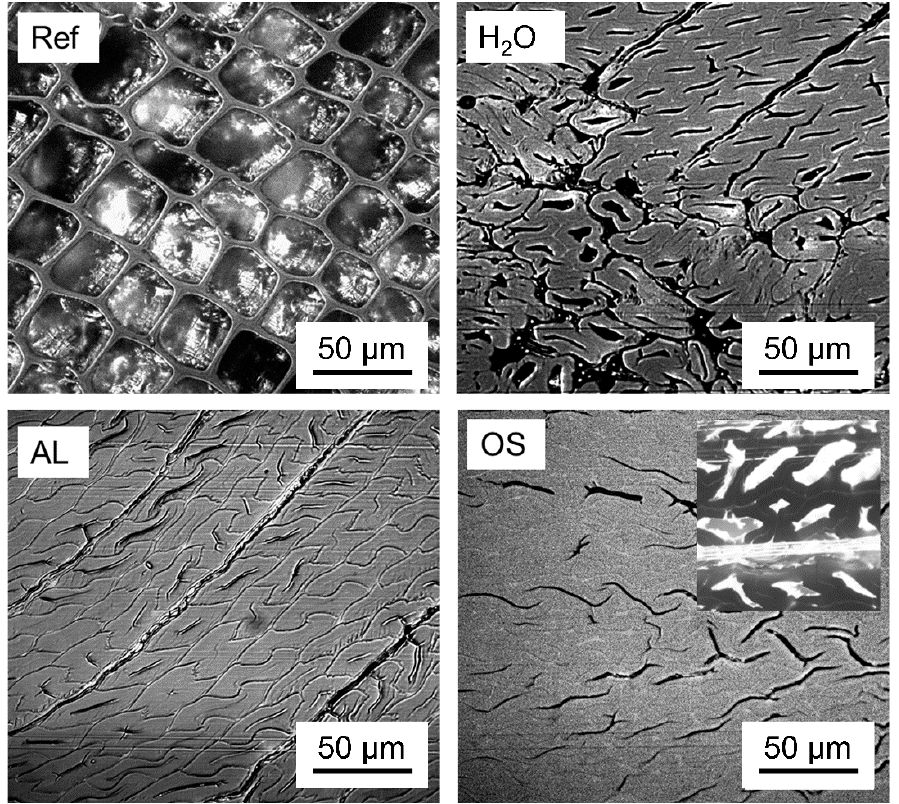
Figure 1. Representative incident light microscopy of untreated reference samples (Ref), samples densified after soaking with water (H 2 O), densified after alkali-delignification (AL), and densified after organosolv delignification (OS); Inset shows incomplete collapse of earlywood. Table 3. Comparison of thickness and density of native, densified and densified chemically treated spruce veneers. ( n = 5 for Ref; n = 5 for H 2 O; n = 5 for AL; n = 5 for OS).